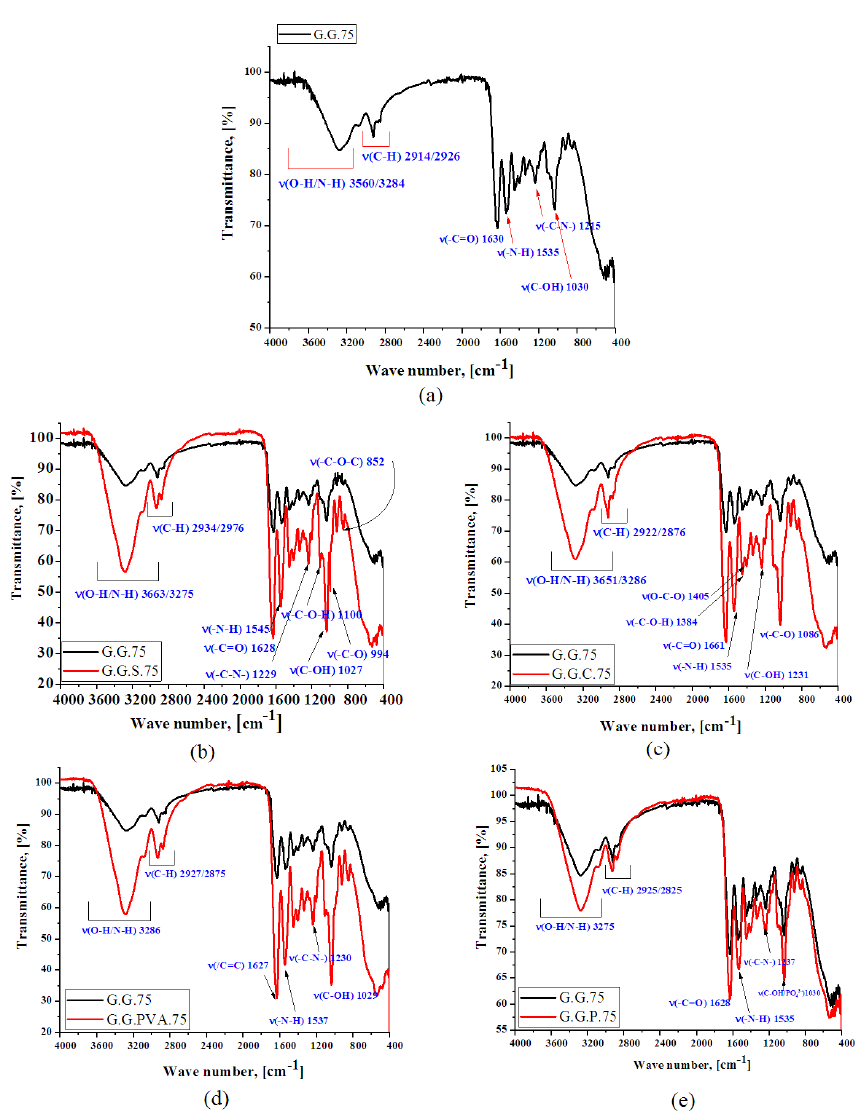
Figure 8. FTIR spectra of gelatin-based composites (G.G.75) ( a ); (G.G.75 and G.G.S.75) ( b ); (G.G.75 and G.G.C.75) ( c ); (G.G.75 and G.G.PVA.75) ( d ); and (G.G.75 and G.G.P.75) ( e ).